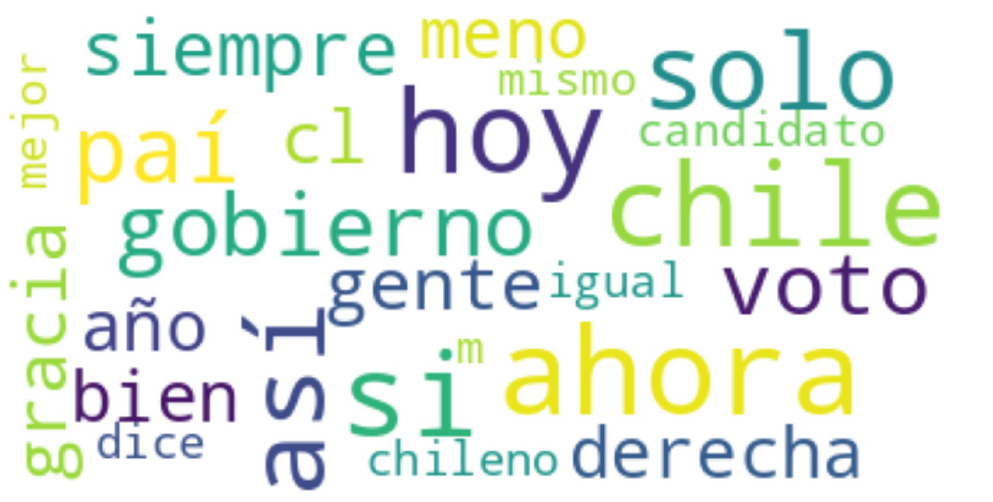
Figure 6. Top words for the total sample in the word